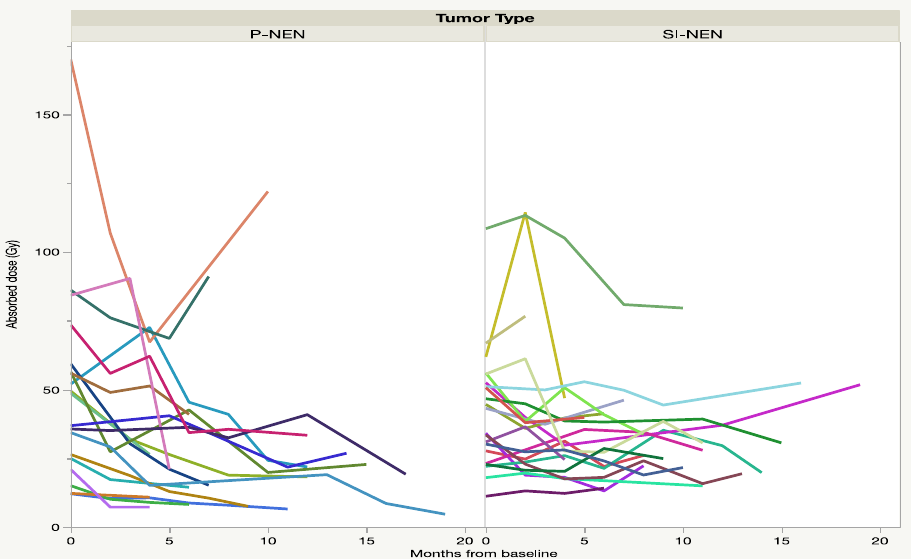
Figure 5. P-NEN tumor dose (Gy) at each cycle ( n = 20) and SI-NEN tumor dose (Gy) at each cycle ( n = 21) in patients with low to moderate tumor burden. Liver tumor burden I & II was assessed on scintigraphy during the first PRRT cycle (Table 1). Each line represents one tumor.